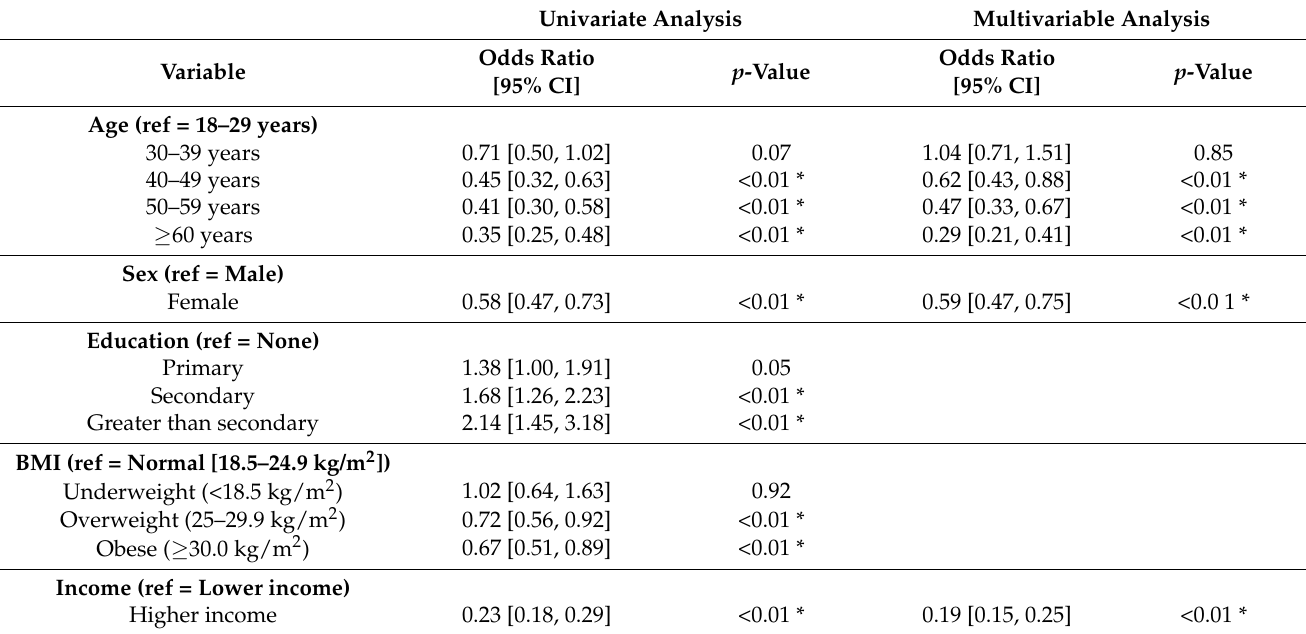
Table 8. Associations between sociodemographic characteristics and high home oil consumption among the study